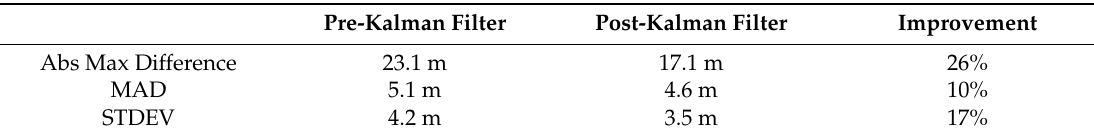
Table 2. Statistical evaluation of elevation differences in respect to the photogrammetric